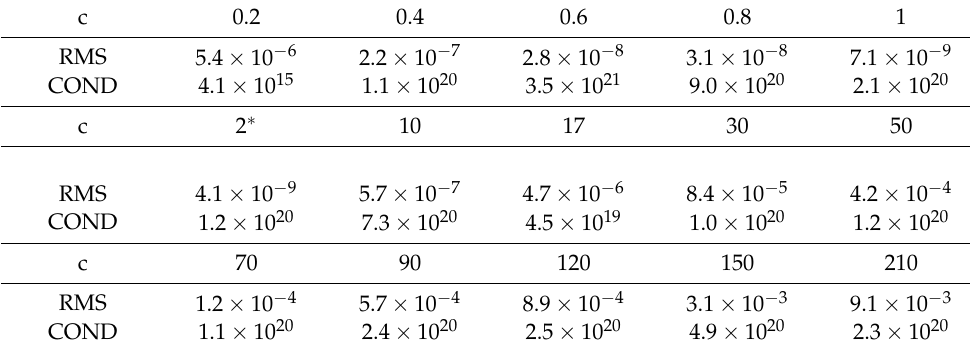
Table 5. N d = 400, N t = 676.